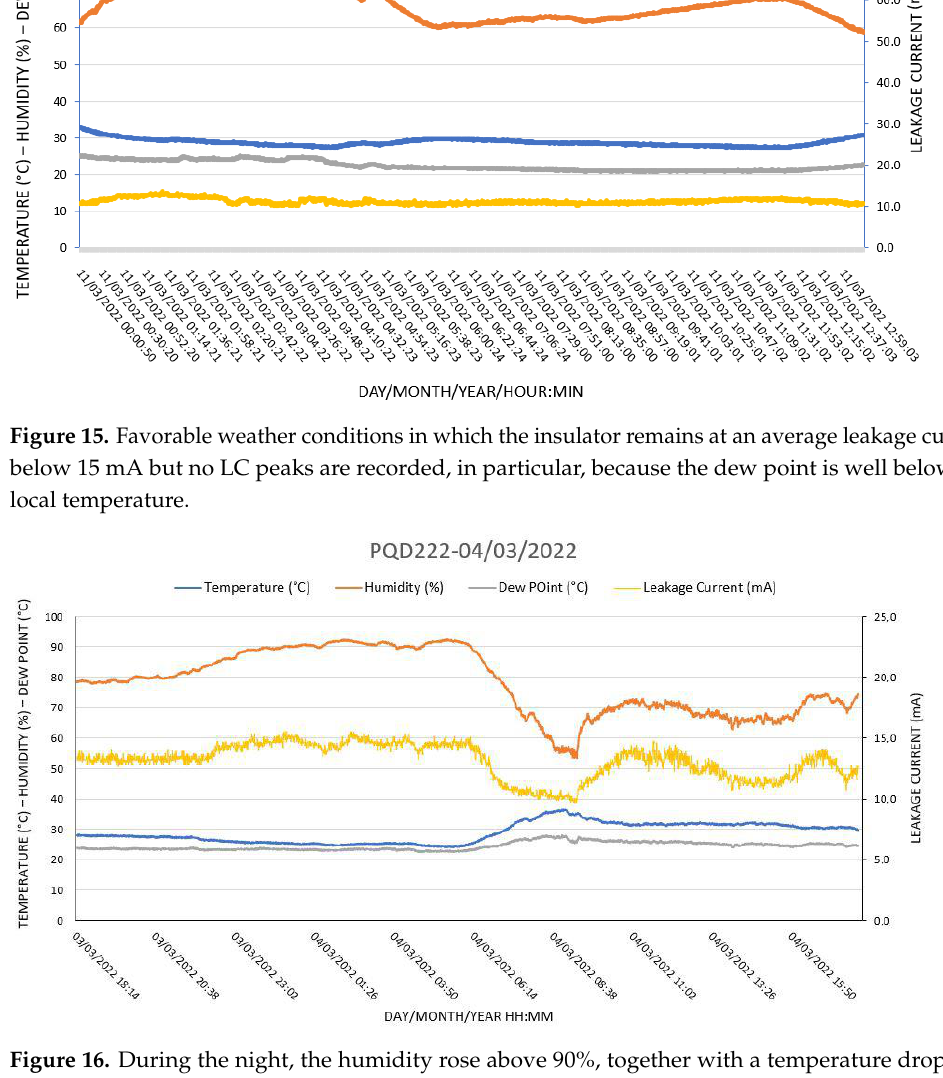
Figure 15. Favorable weather conditions in which the insulator remains at an average leakage current below 15 mA but no LC peaks are recorded, in particular, because the dew point is well below the local temperature.